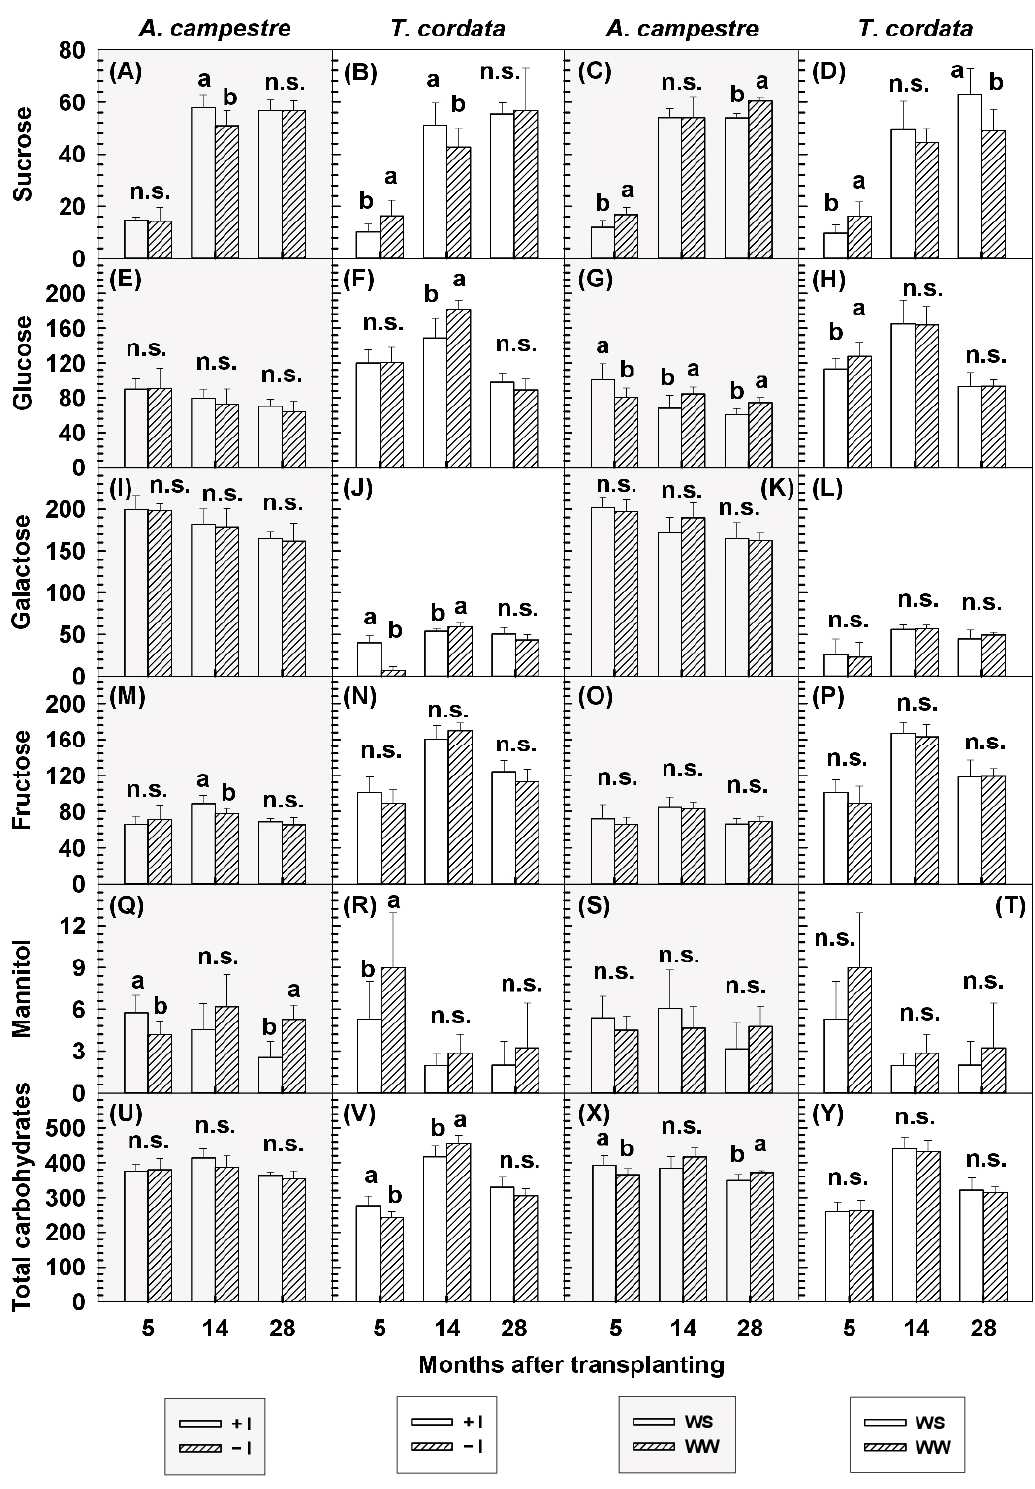
Figure 5. Effect of mycorrhizal inoculation and water regime in the nursery on leaf soluble car- bohydrate content (expressed as µ mol g − 1 of dry weight) of Acer campestre L. and Tilia cordata Mill. measured 5, 14 and 28 months after transplanting. +I, inoculated plants; − I, non-inoculated plants; WW, well-watered plants; WS, water-stressed plants. Plots in gray represent carbohydrate values of Acer campestre , whereas plots in white represent values of Tilia cordata . ( A – V , X , Y ) Within each panel and sampling date, different letters indicate significant differences between +I and − I plants and between WW and WS plants at p ≤ 0.05 and p ≤ 0.01, respectively; n.s. indicates no significant